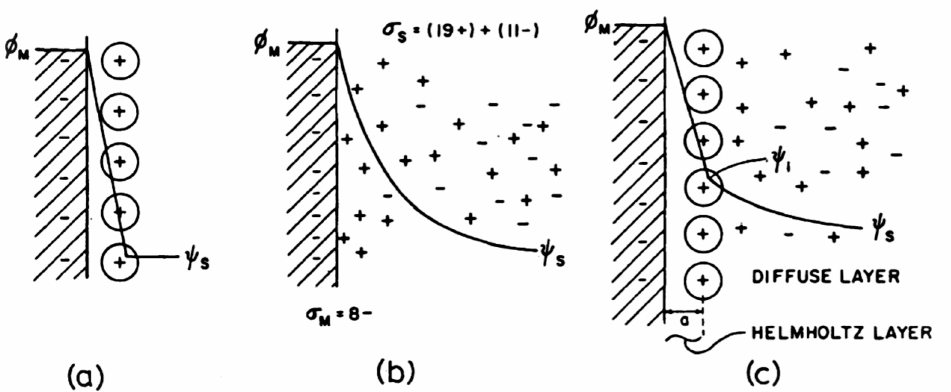
Figure 4. The changing model of the double layer: ( a ) Helmholtz model, ( b ) Gouy point-charge model, ( c ) Stern model for finite ion size with thermal distribution, combining the Helmholtz and Gouy models. Reprinted with permission from Ref. [3]. 1999,